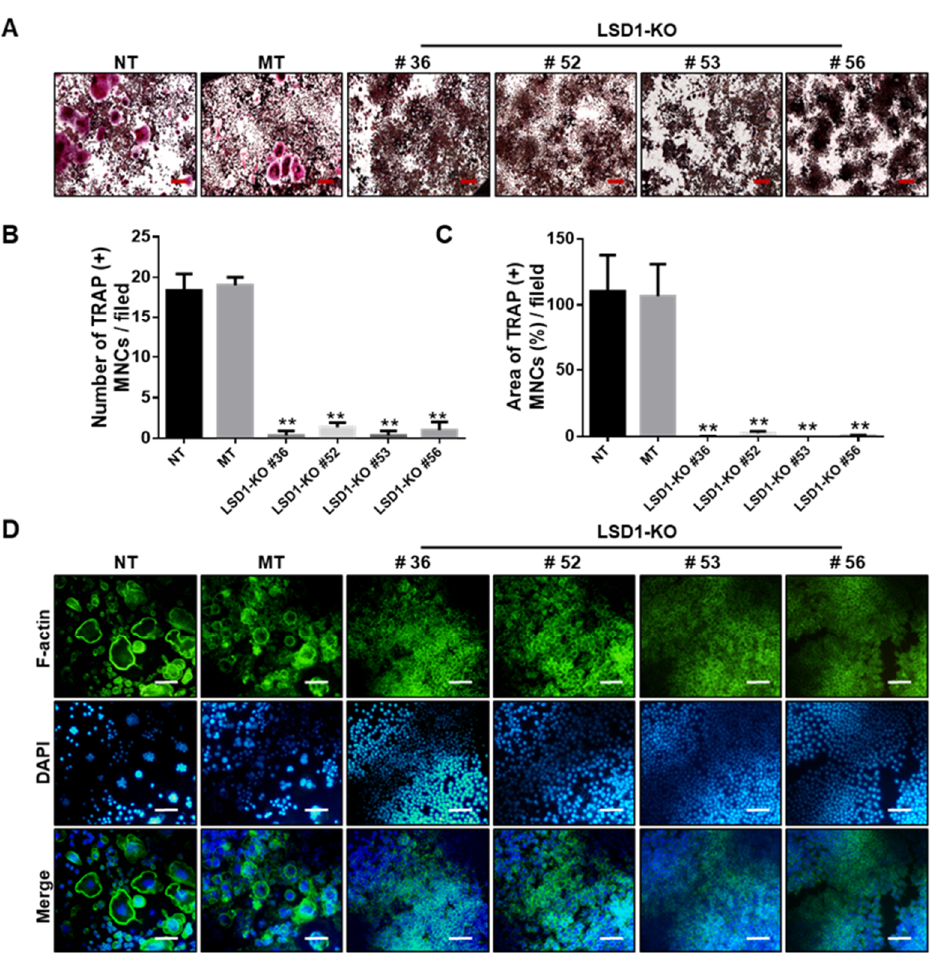
Figure 6. LSD1 deficiency suppresses RANKL-induced osteoclast differentiation and F-actin ring formation. ( A ) TRAP staining was performed to determine differentiated osteoclasts from trans- fected Raw 264.7 cells. Representative images of TRAP staining are shown. Scale bar = 200 µm. ( B , C ) Number and area of TRAP (+) MNCs were calculated from three randomly selected images in each group by Image J software. ** p < 0.01 versus the MT group. ( D ) Transformed Raw 264.7 cells were incubated with RANKL (50 ng/mL) for 5 days. Cells were stained with FITC-conjugated phalloidin and pictures were captured by the fluorescence microscope. Scale bar = 100 µm. NT: no transfection, MT: mock transfection.